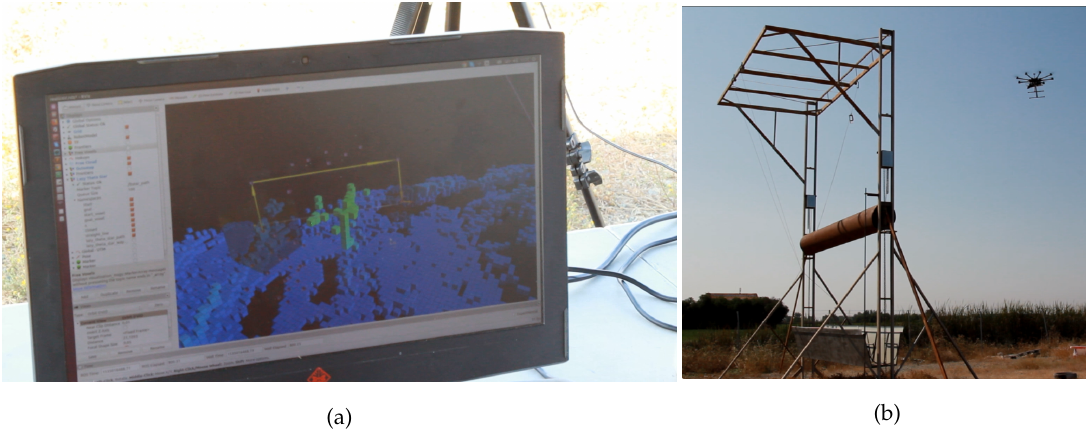
Figure 10. Photographs from outdoor flights. The UAV avoids an obstacle autonomously ( b ) that appears green in the map ( a ) that is generated in real time. In ( a ), the small cubes’ edges are 0.5